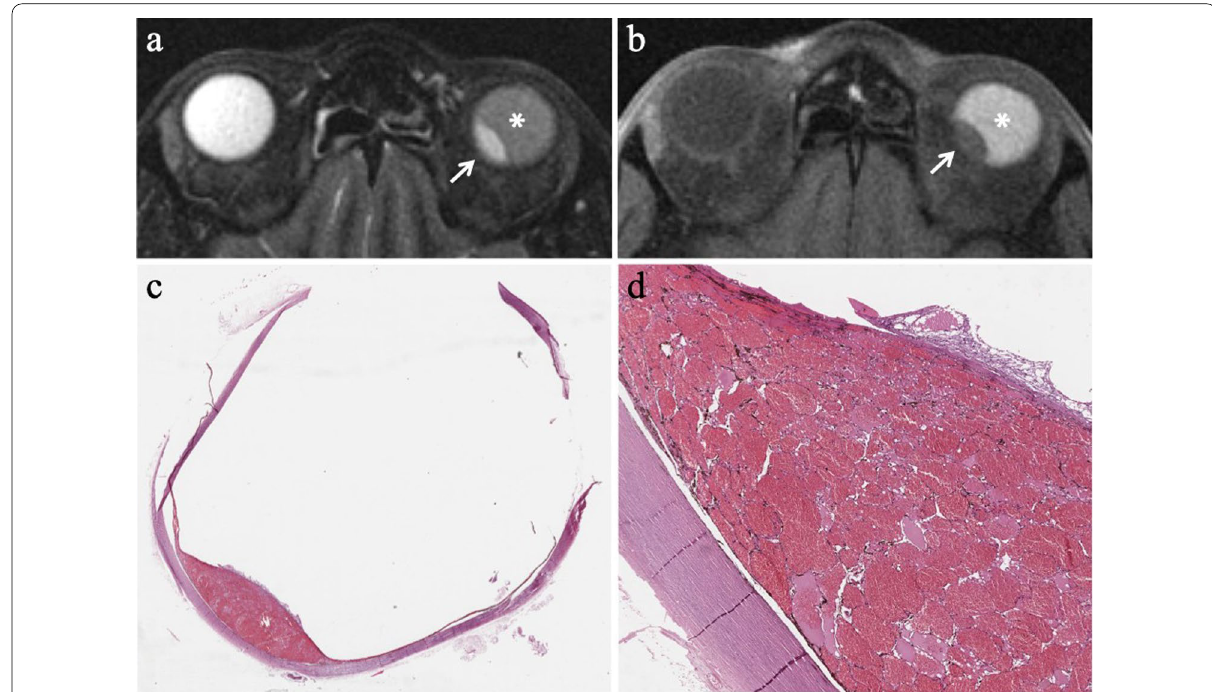
Fig. 17 A 53-year-old woman with a choroidal hemangioma of the left eye treated with photodynamic therapy. The patient underwent secondary enucleation about seven years after the treatment because of vitreous hemorrhage. Axial ( a ) T2-weighted turbo spin-echo STIR and ( b ) fat-suppressed T1-weighted images show a lentiform intraocular mass along the postero-medial aspect of the globe (white arrows). Compared with the contralateral (normal) vitreous body, the lesion is isointense on T2-weighted image and slightly hyperintense on T1-weighted image. The vitreous body of the left eye is diffusely hypointense on T2-weighted and hyperintense on T1-weighted sequences because of extensive vitreous hemorrhage (asterisks). ( c ) Histological examination: low magnification showing a nodular, vascular mass protruding into the posterior chamber of the eye (H&E, original magnification 25). ( d ) At higher magnification the mass was composed of numerous, dilated, cavernous vascular spaces × lined by flattened endothelial cells and filled with red blood cells and fibrinoid material (H&E, original magnification 100). The findings are × consistent with choroidal